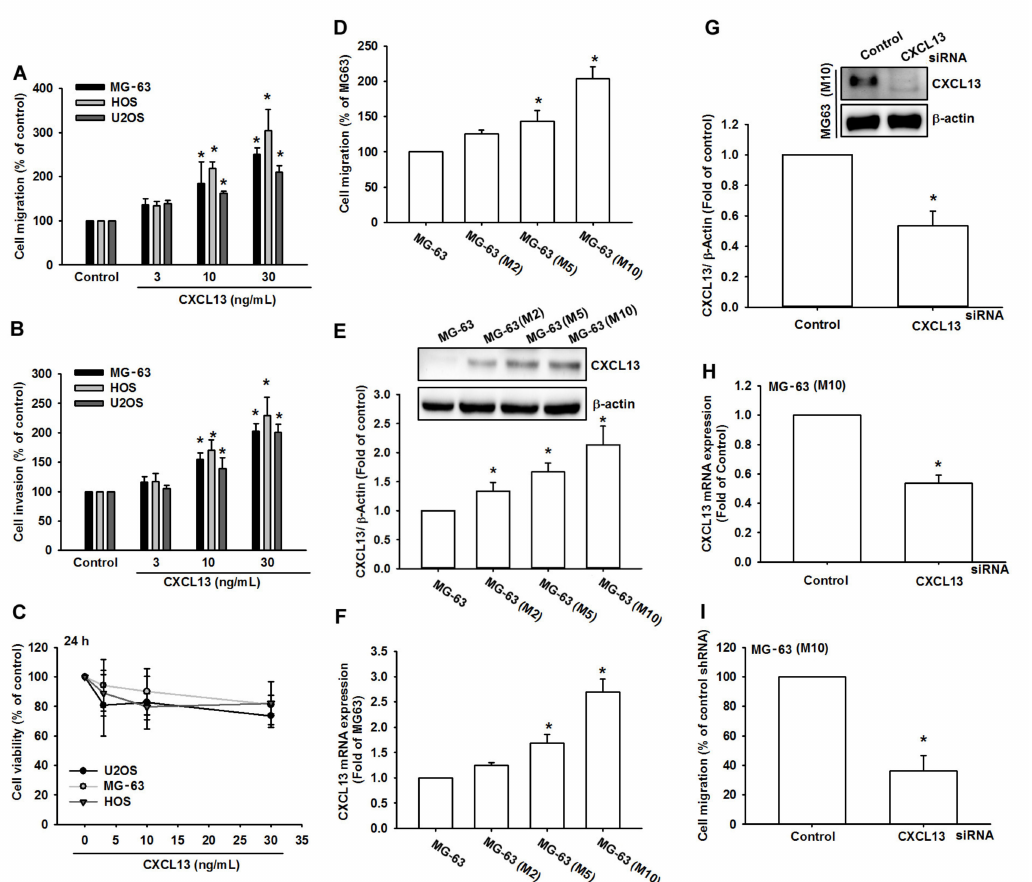
Figure 1. The chemokine (C-X-C motif) ligand 13 (CXCL13) increases migration and invasion in human osteosarcoma. ( A , B ) Cells were incubated with CXCL13 (3–30 ng / mL) and the Transwell assay determined in vitro migratory and invasion activity after 24 h. ( C ) Cells were incubated with CXCL13 for 24 h and cell viability was examined by the MTT assay. ( D – F ) Migratory ability and CXCL13 expression of the indicated cells was examined by Transwell, Western blot and qPCR assays. ( G – I ) Cells were transfected with CXCL13 siRNA then stimulated with CXCL13; CXCL13 expression and migratory potential was examined by Western blot, qPCR, and Transwell assays. * p < 0.05 compared with the control